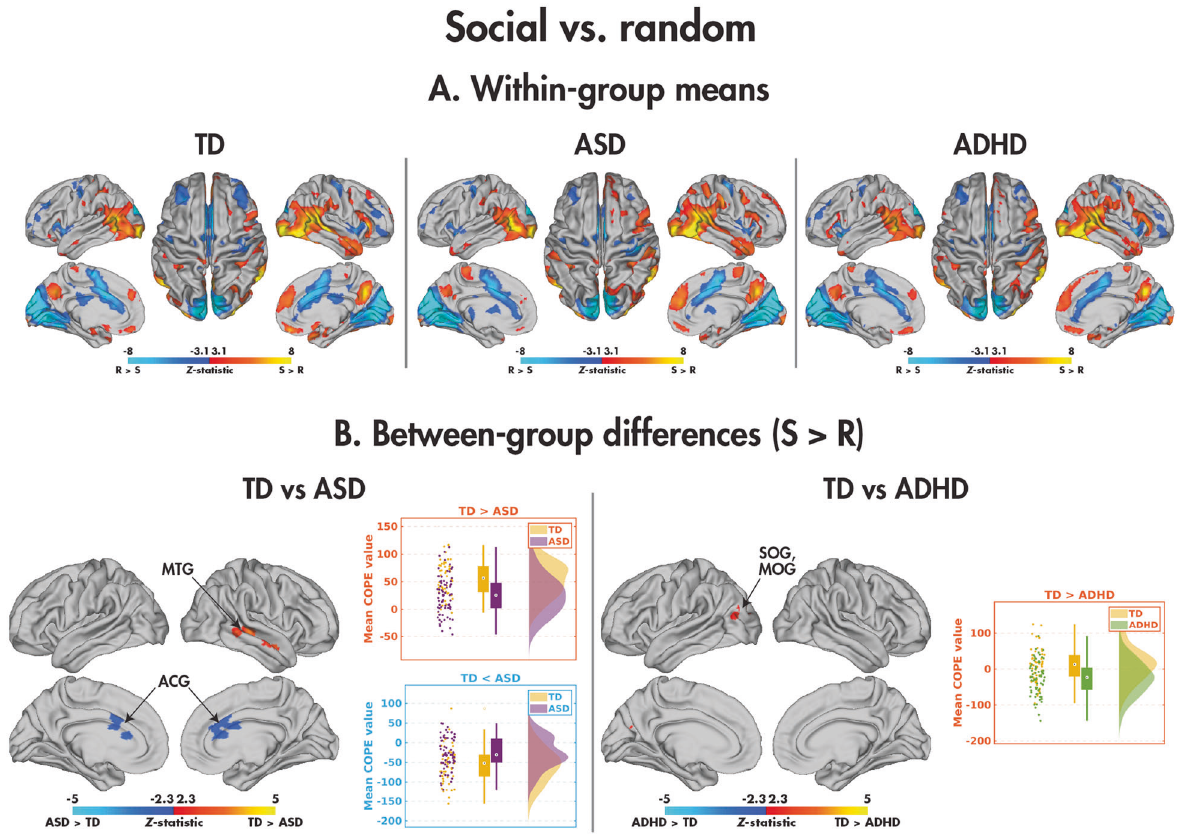
Fig. 3 Comparing the social and random conditions in the SAT. Signi fi cant ( p corr < 0.05) within-group effects are shown for the TD, ASD, and ADHD participants ( A ), and signi fi cant ( p corr < 0.05) between-group effects are shown for the TD vs. ASD and TD vs. ADHD participants ( B ); no differences were observed between the ASD and ADHD groups.